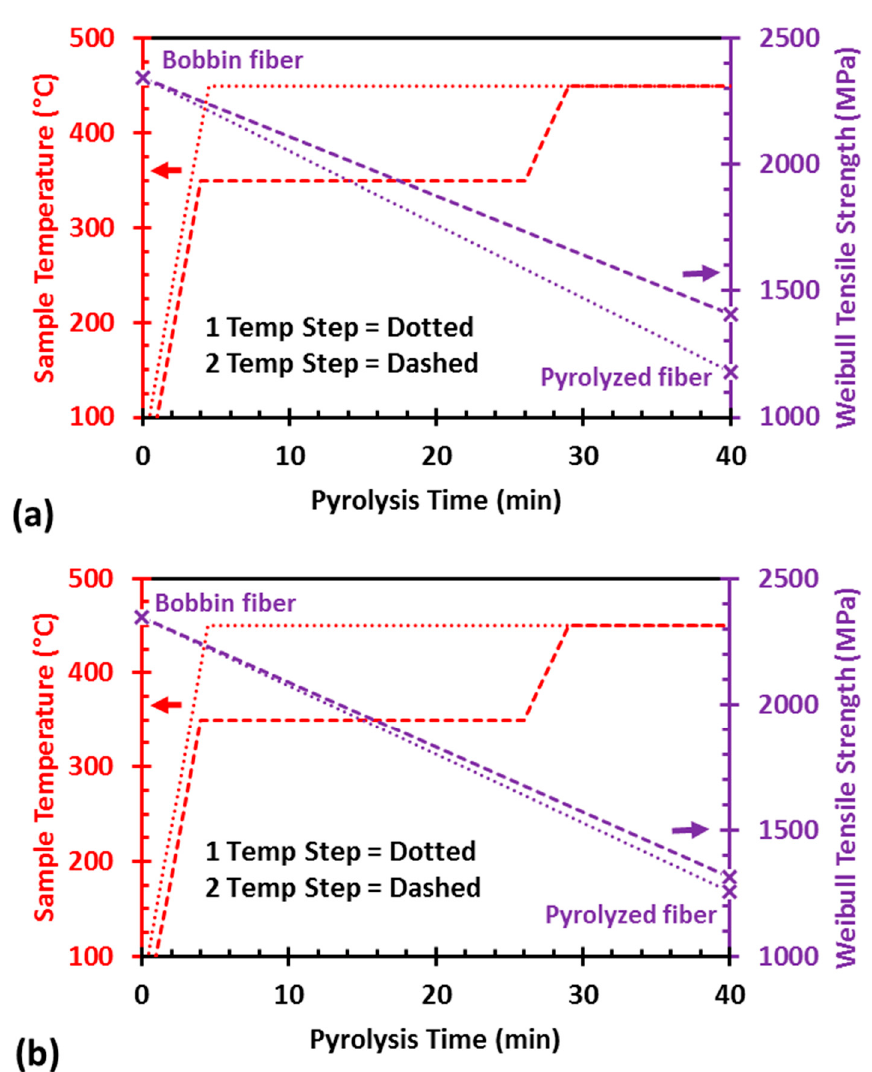
Figure 3. Measured drops in glass filament Weibull characteristic tensile strength from virgin fiber (represented by the SMC E-glass bobbin sample) to fibers recovered by pyrolysis: ( a ) wind blade fibers, ( b ) SMC fibers. Comparison against schematic temperature process curves illustrates correlation between reduced higher temperature exposure and improved recovered filament strength.